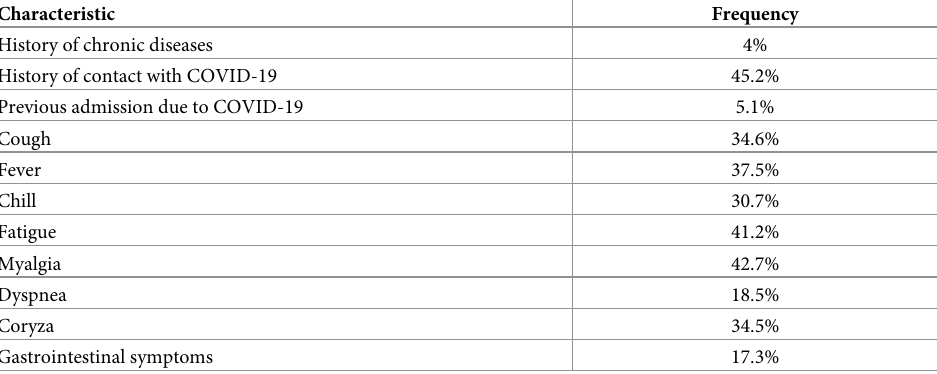
Table 1. Characteristics of the patients.